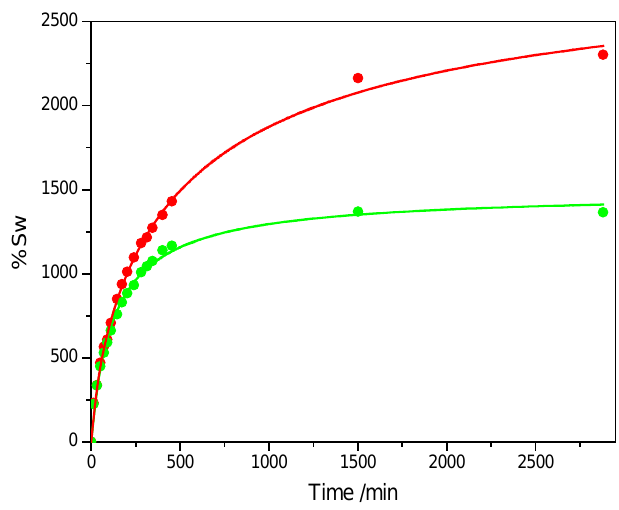
Figure 3. Release kinetics of ( a ) DA and ( b ) AA from the PAAm ( ● ) and NanoC ( ● ). Figure 2. Swelling kinetic of ( ● ) PAAM and ( ● ) NanoC. Using the experimental kinetics data (concentration vs. time), it was possible to calculate the initial release rate ( υ ) as the derivate of the concentration vs. time in the initial stages of the release process (Table 2).